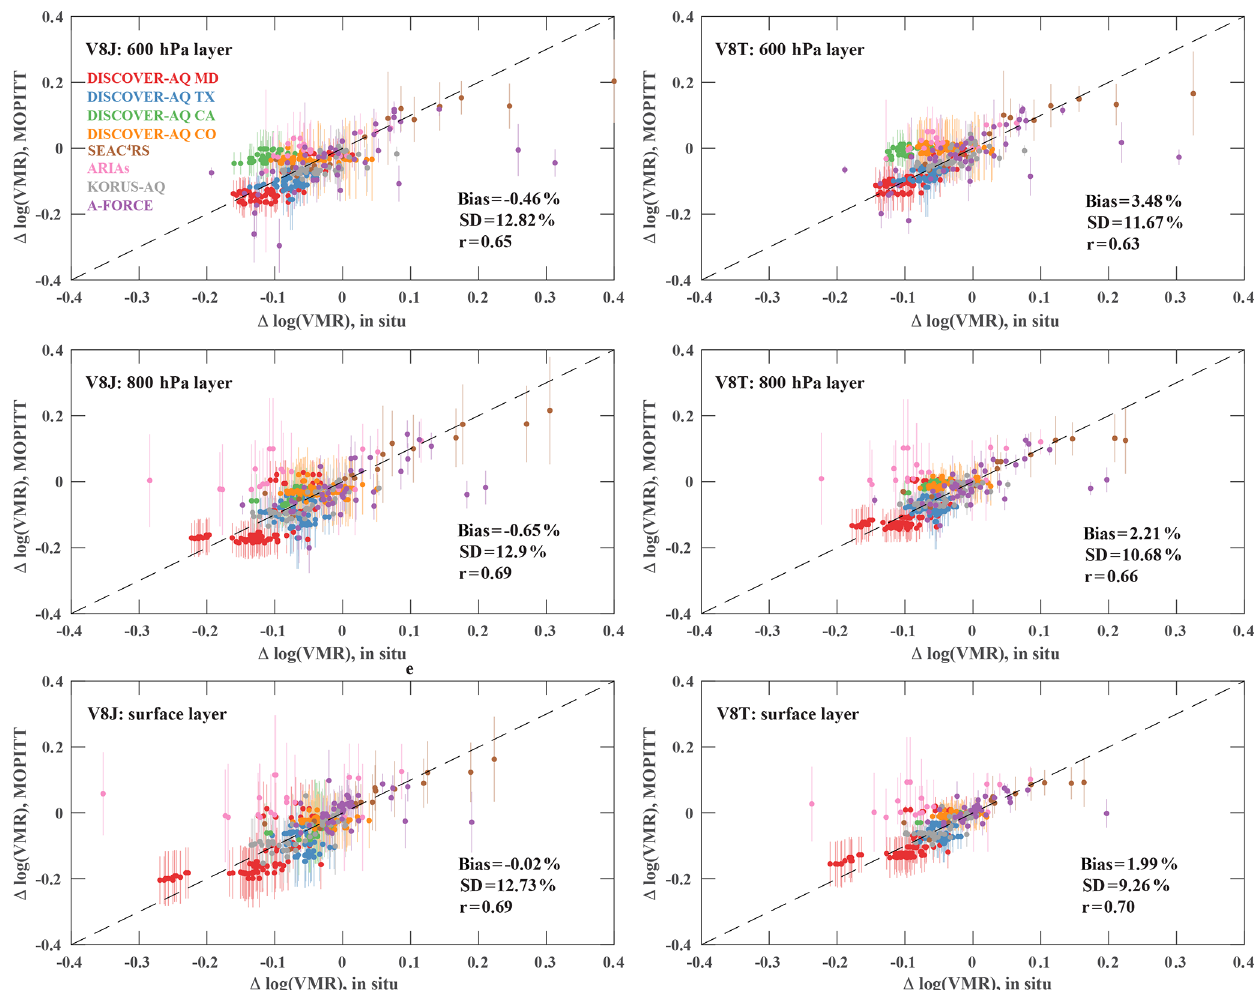
Figure 4. MOPITT V8J and V8T validation results over both urban and non-urban regions at 600hPa layer, 800hPa layer, and the surface layer in terms of (cid:49) log 10 ( VMR ) . (cid:49) log 10 ( VMR ) is defined as x rtv – x a for MOPITT profiles and x transformed – x a for the in situ profiles. The use of (cid:49) log 10 ( VMR ) allows us to remove the impact of the a priori in the comparisons. The variability of the MOPITT data used to calculate each of the plotted mean values is represented by the vertical error bars. The dashed lines are one-to-one ratio